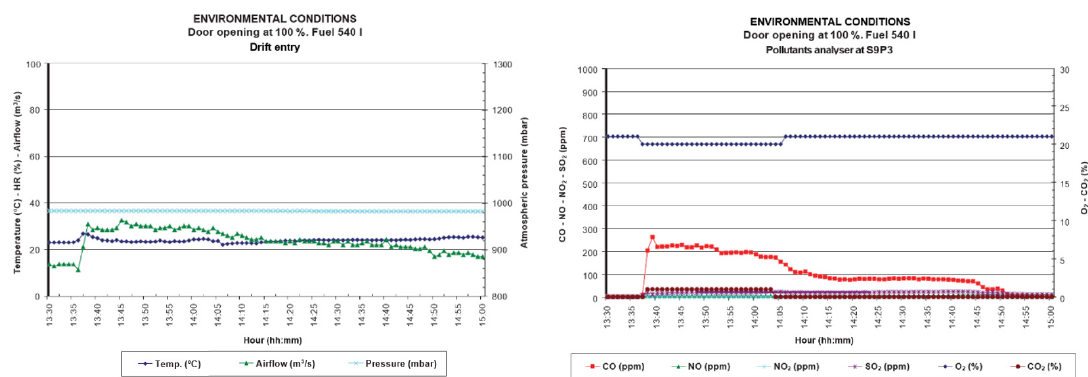
Figure 8. EvolutioSn of the environmental conditions over time; test 4.